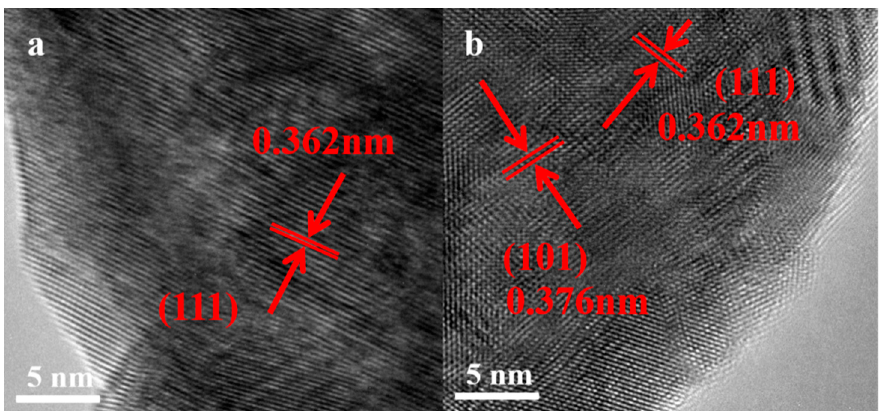
Figure 3. High-resolution TEM images of ( a ) BaF 2 , ( b ) BaCl 0.25 F 0.75 .